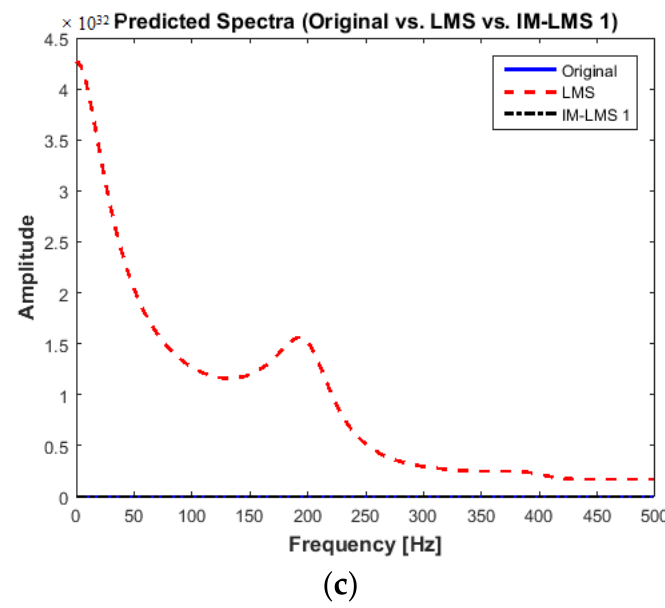
Figure 4. Simulation results in time domain with a single sinusoid at 100 Hz. ( a ) Time domain tracking with LMS and internal model LMS 1 methods; ( b ) estimation error; ( c ) predicted spectra.